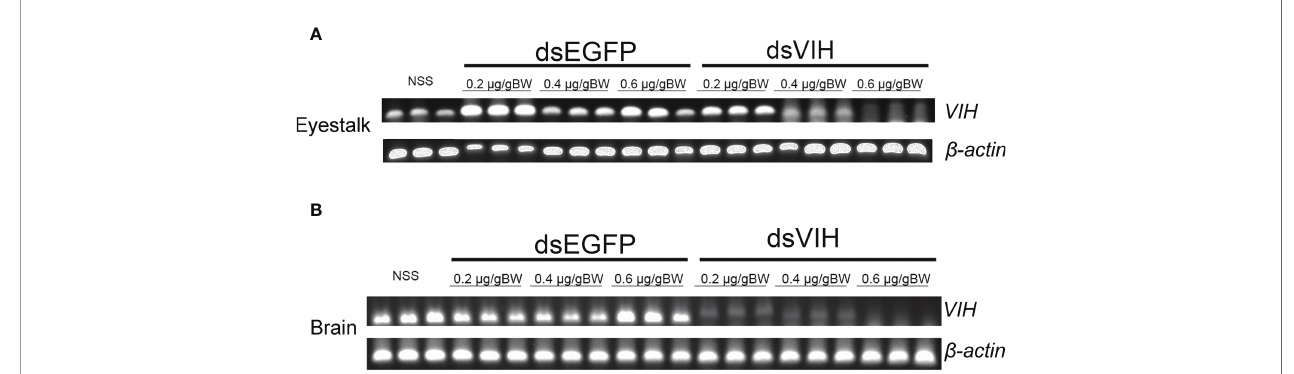
FIGURE 2 | Dose-dependent effects of dsRNA-VIH, dsRNA-EGFP, and vehicle control (NSS) in sequestering the VIH gene expression in (A) eyestalk and (B) brain. In both organs, the most potent dose of dsRNA-VIH to inhibit the VIH gene expression was 0.6 µg/g BW. No inhibitory effect on VIH gene expression was observed by the injection of either the dsRNA-EGFP and vehicle